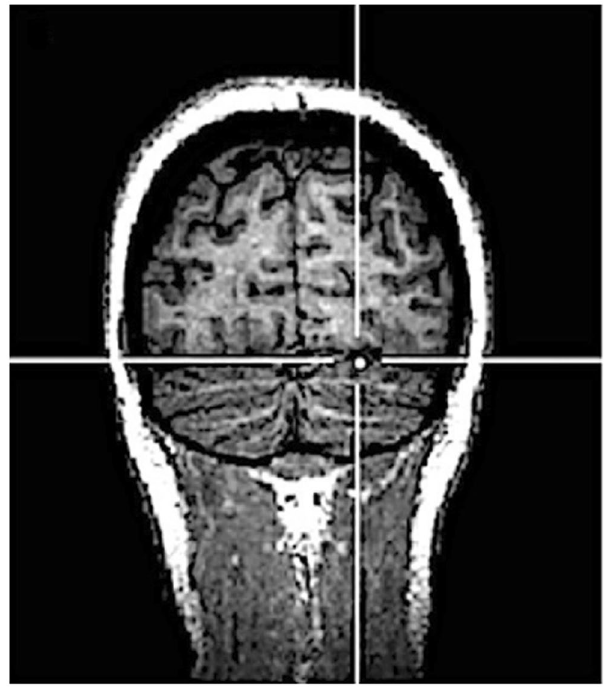
Figure 2. Anatomical Talairach coordinates of the targeted cerebellar site (x = 22, y = − 75, z = −